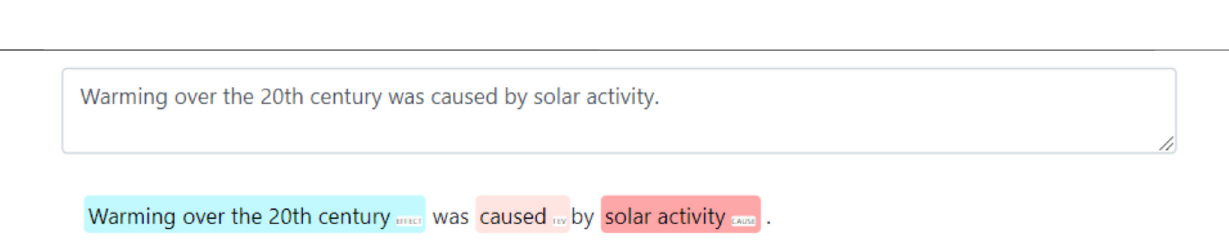
Frontiers in Big Data |